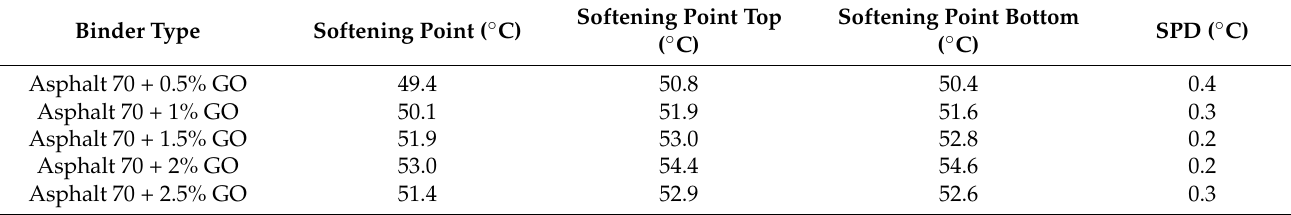
Table 3. Storage stability (separation test results) of GO-modified